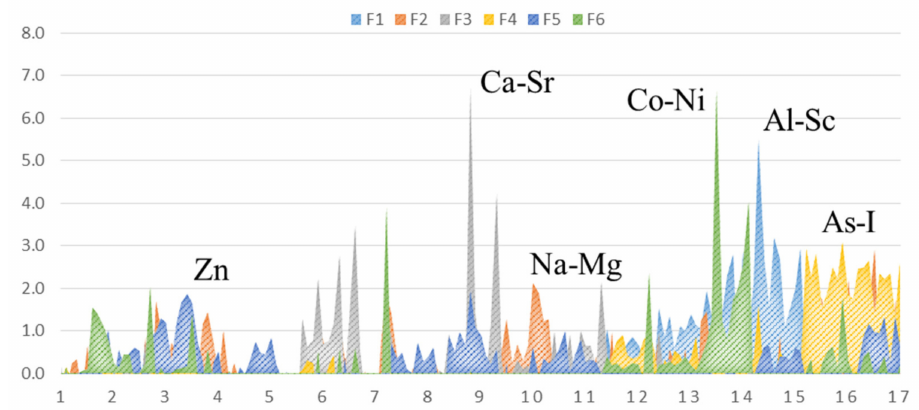
Figure 3. The elements with the highest factor scores in the factor analysis among studied